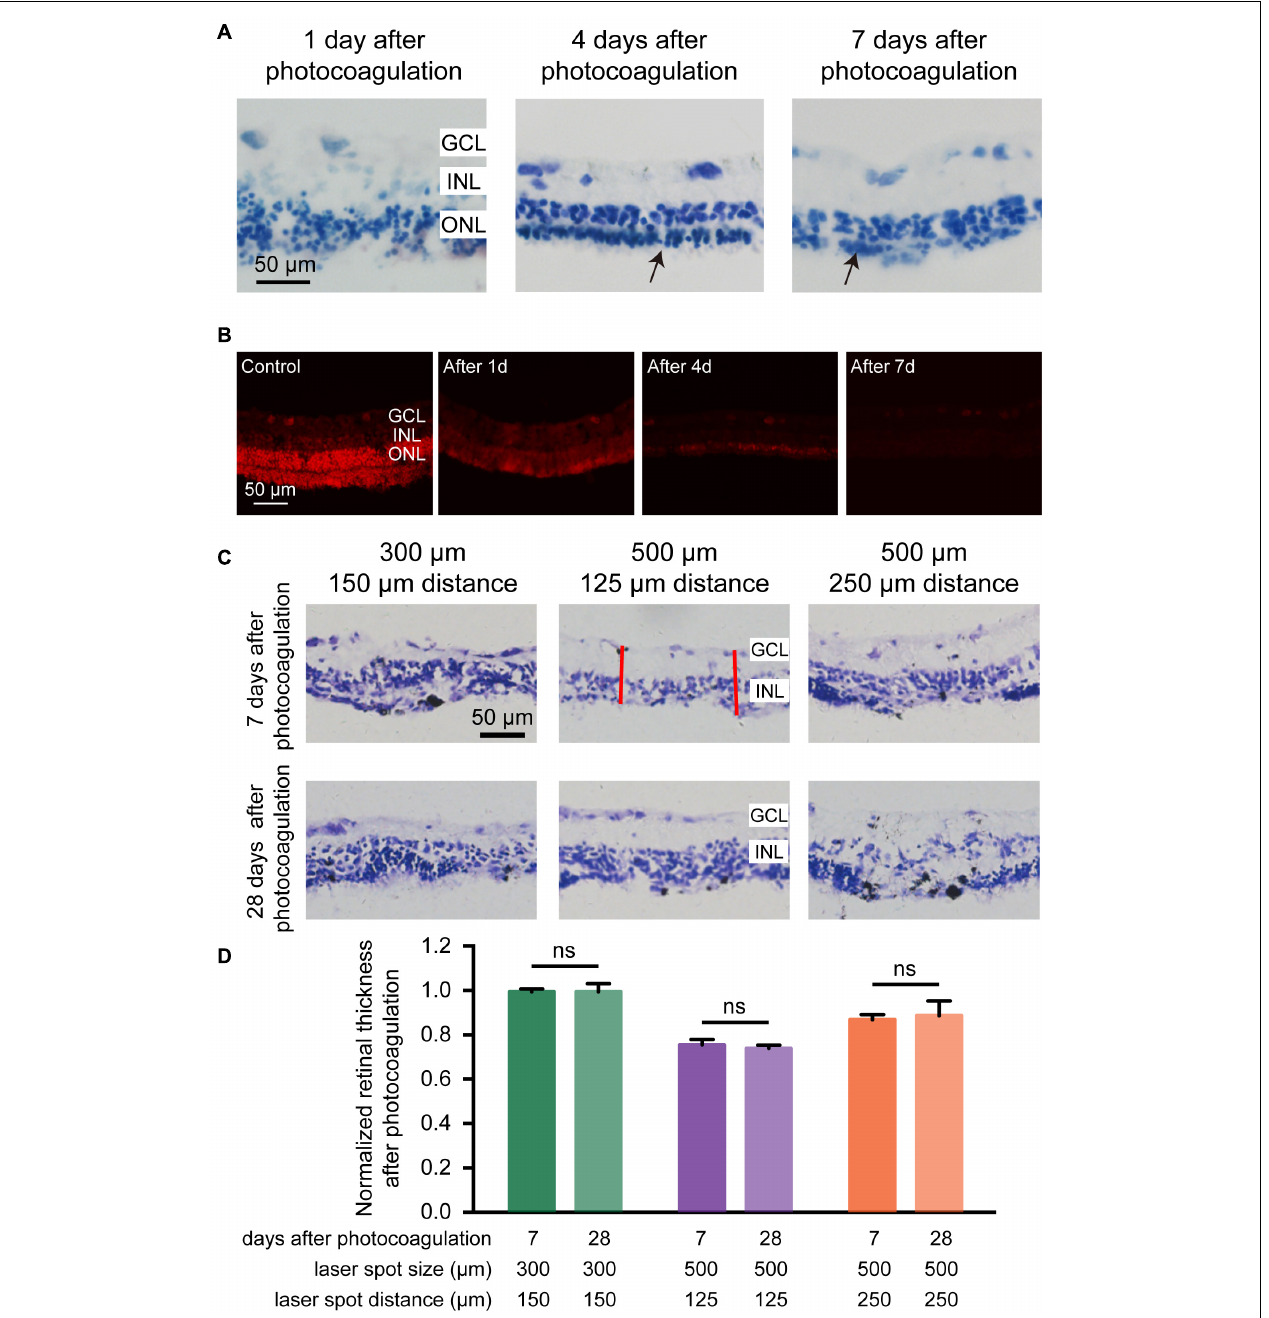
FIGURE 4 | Histomorphology of rabbit retinas and normalized retinal thickness after photocoagulation surgery. (A) Histologic images at 1, 4, and 7 days after photocoagulation with 100 mW laser power and 50 ms pulse duration. Histologic images for 500 µ m laser spot size and 0 µ m laser spot distance. The arrow points to the remnant cells of the ONL. Scale bar = 50 µ m. (B) DHE staining of control retinal sections and local damage retinal sections at 1, 4, and 7 days after photocoagulation with 100 mW laser power and 50 ms pulse duration. Stained images for 500 µ m laser spot size and 0 µ m laser spot distance. Scale bar = 50 µ m. GCL, ganglion cell layer; INL, inner nuclear layer; ONL, outer nuclear layer. (C) Histologic sections of rabbit retinas 7 and 28 days after photocoagulation with 100 mW laser power and 50 ms pulse duration. Histologic images for 300/150, 500/125, and 500/250 µ m laser spot size/distance. GCL, ganglion cell layer; INL, inner nuclear layer. Scale bar = 50 µ m. The red line represents two locations randomly taken in each section for measuring the thickness of the retina after photocoagulation in the photocoagulation area. (D) Normalized photocoagulation retinal thickness in different sections at 7 and 28 days after photocoagulation under the same conditions as in (A) . Normalized retinal thickness is the ratio between retinal thickness in photocoagulation area and retinal thickness in nonphotocoagulation area. (7 days after photocoagulation: n 300 / 150 µ m = 8 slices, n 500 / 125 µ m = 8 slices, n 500 / 250 µ m = 6 slices; 28 days after photocoagulation: n 300 / 150 µ m = 5 slices, n 500 / 125 µ m = 6 slices, n 500 / 250 µ m = 4 slices). Data were presented as Mean ±